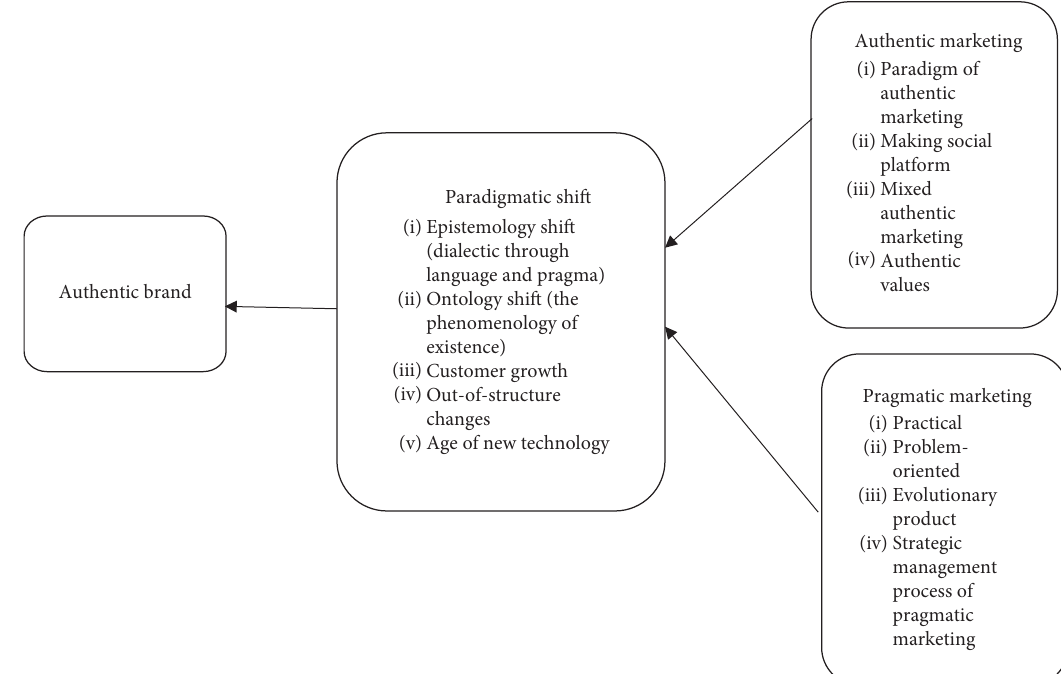
Figure 1: The authentic and pragmatic marketing process model